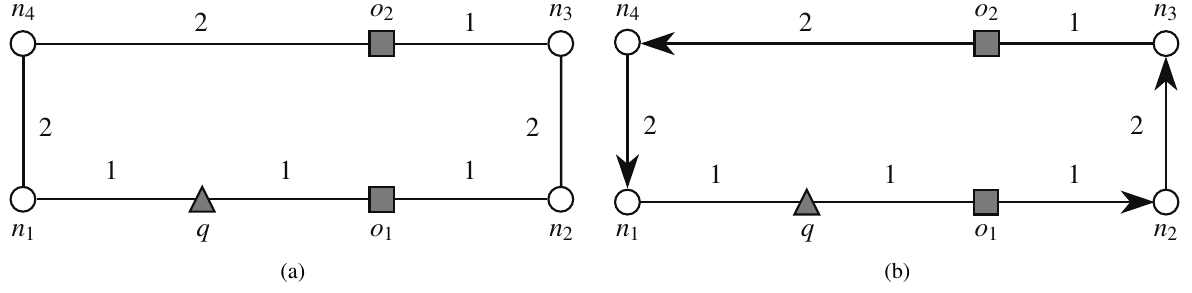
Figure 2: Examples (a) undirected road network (b) directed road